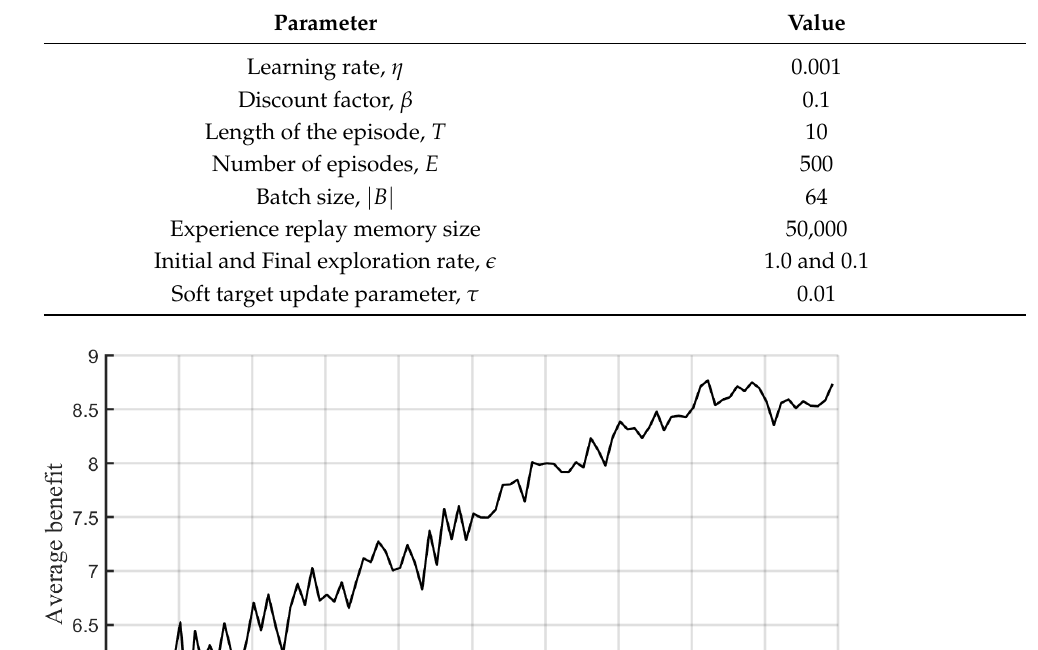
Table 2. Hyperparameters for DRL.